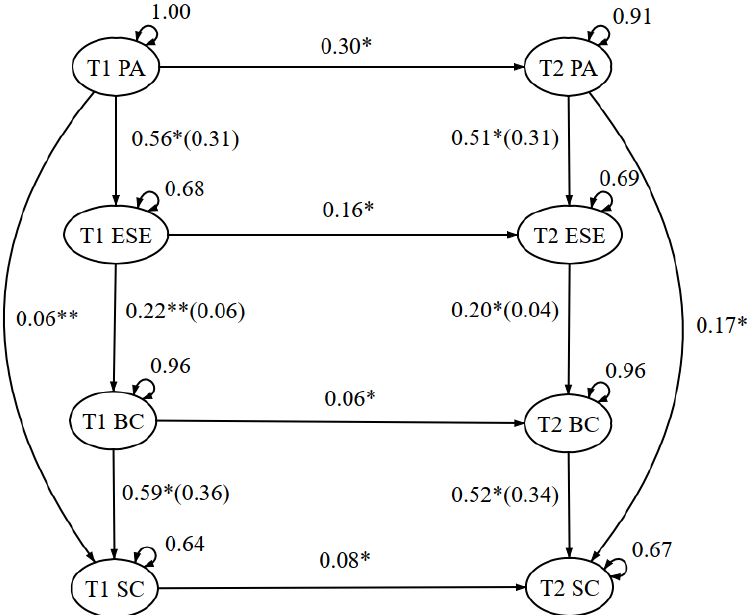
Figure 1. Exercise and Self-Esteem Model Revised with Self-Compassion—Panel Analysis Framework. Note. Standardized coefficients, total variance explained on the outcome ( R 2 ) and errors are presented. R 2 is presented in brackets, in the form of β ( R 2 ). * p < 0.05, ** p < 0.01. T1 PA = Time 1 physical activity; T2 PA = Time 2 physical activity; T1 ESE = Time 1 exercise self-efficacy; T2 ESE = Time 2 exercise self-efficacy; T1 BC = Time 1 body compassion; T2 BC = Time 2 body compassion; T1 SC = Time 1 self-compassion; T2 SC = Time 2 self-compassion.